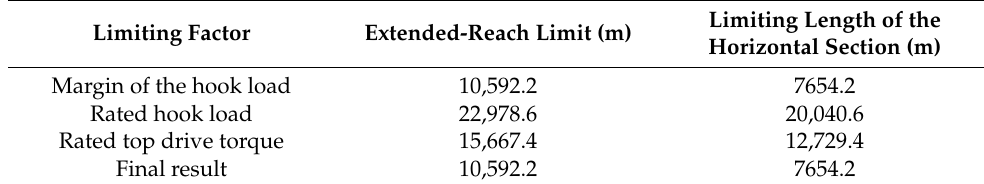
Table 4. Mechanical extended-reach limit of the dual-channel drillpipe drilling.